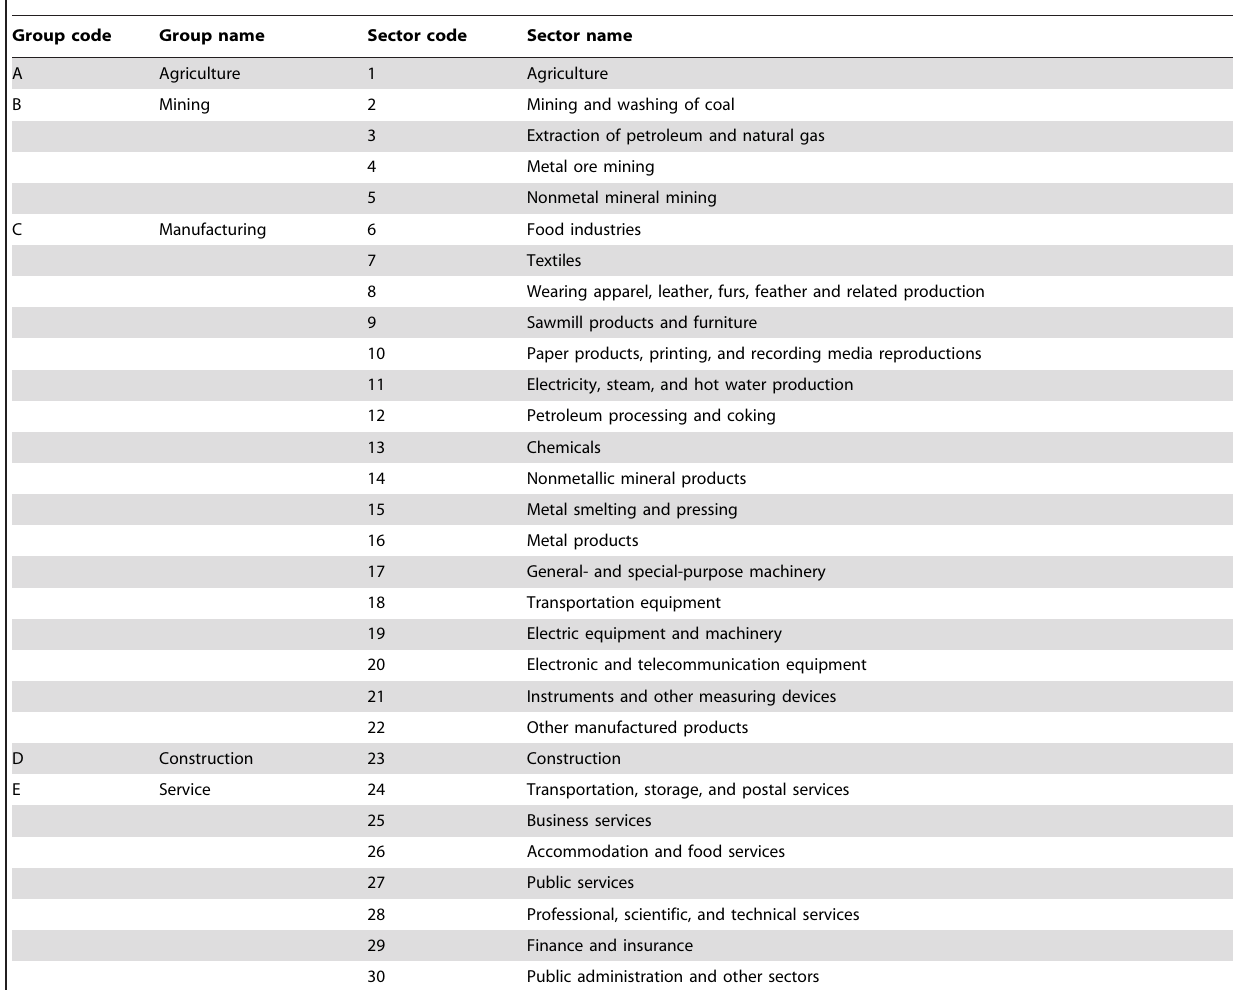
Table 2. Aggregated sectors and groups for input-output analysis [35,40].